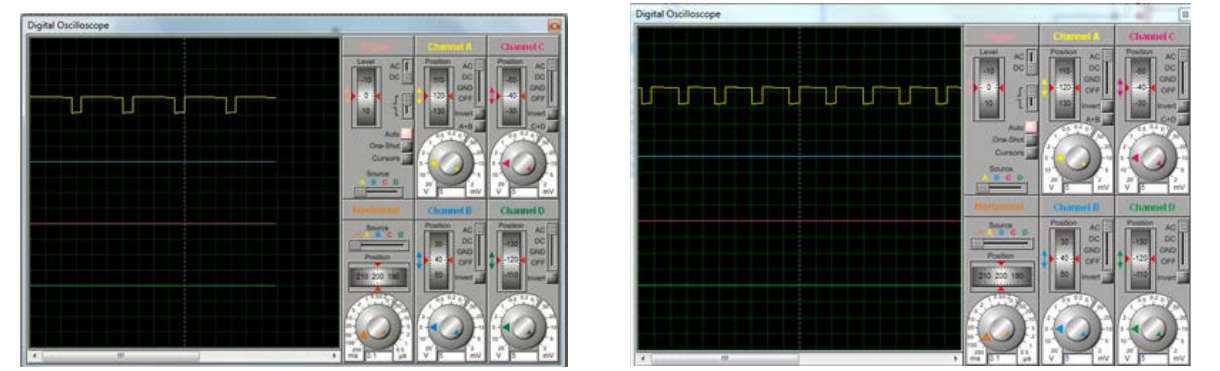
Figure 6. Output signal signal on the oscilloscope when the potentiometer is 50%